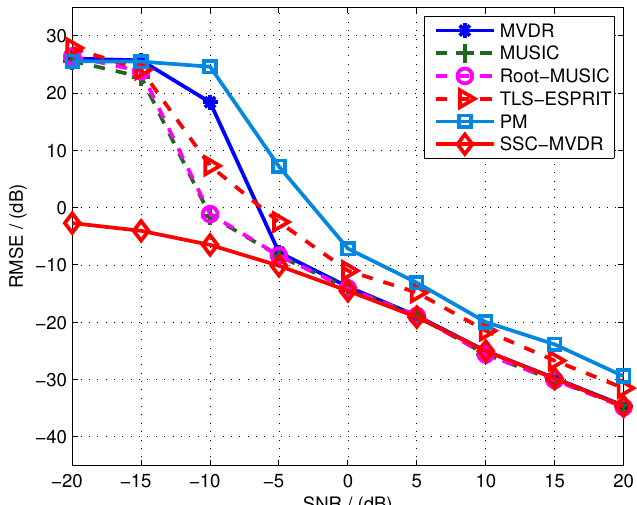
Figure 4. DOA estimation accuracy results obtained by the MVDR method, the MUSIC method, the Root-MUSIC method, the TLS-ESPRIT method, the PM method and the SSC-MVDR method when the number of snapshots is fixed at 100, and the intensity of the acoustic source is gradually increased from − 20 dB to 20